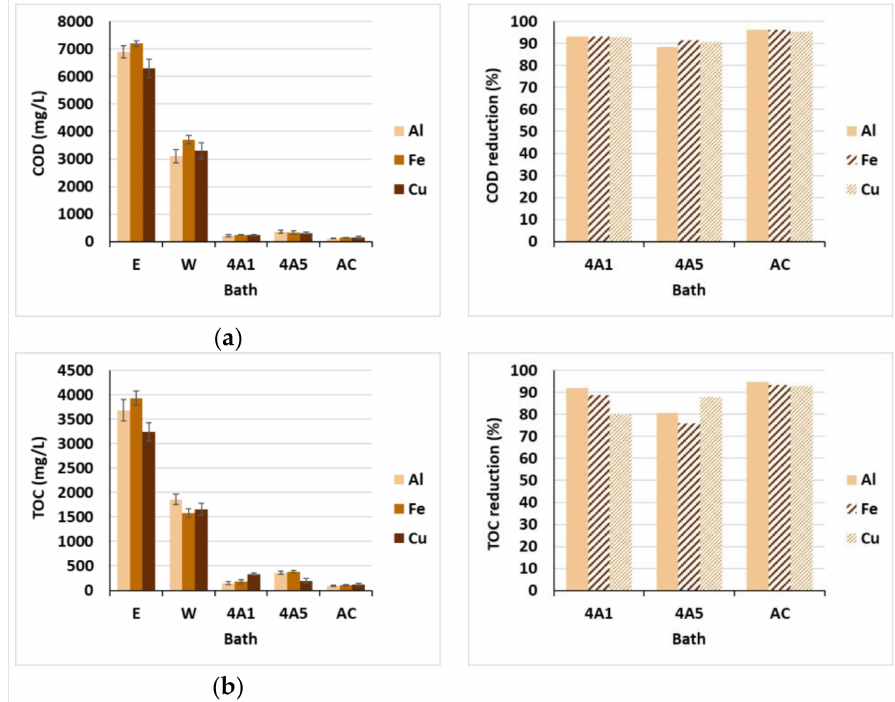
Figure 6. Pollution parameters in baths ( left ) and reduction in pollution ( right ): ( a ) COD; ( b )